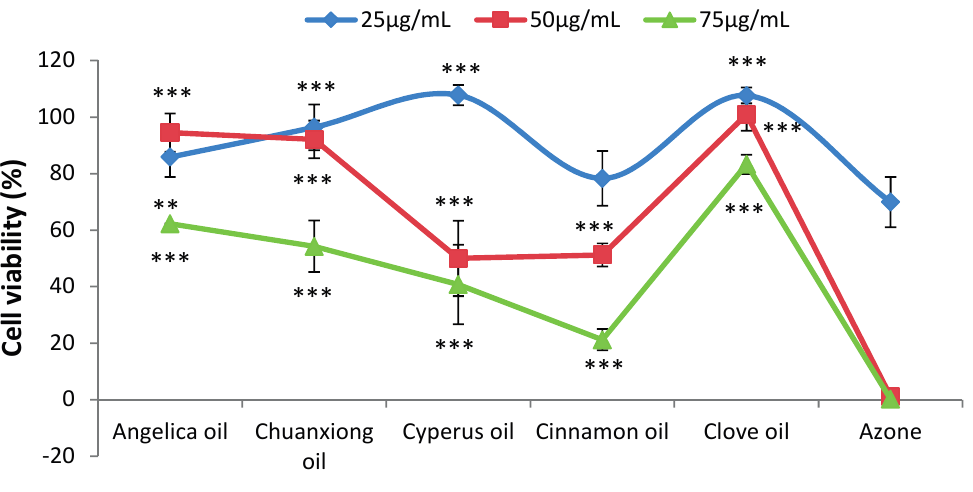
Figure 1. Cytotoxicities of EOs on HaCaT keratinocyte cell lines (n = 6). ** p < 0.01, *** p < 0.001 vs. the Azone group.